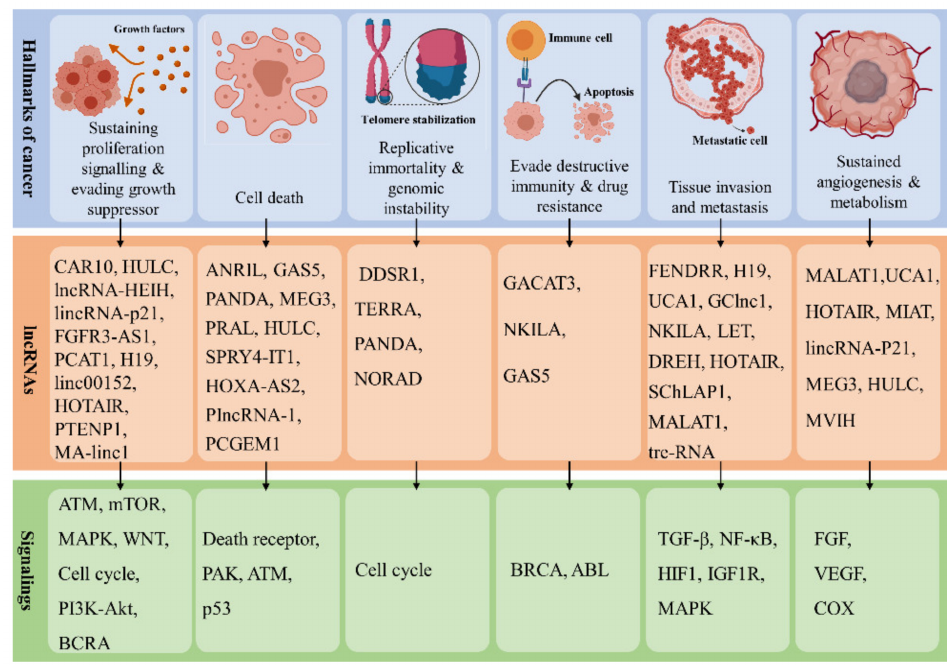
Figure 2. A schematic view of controlling cancer hallmarks and associated signaling pathway by